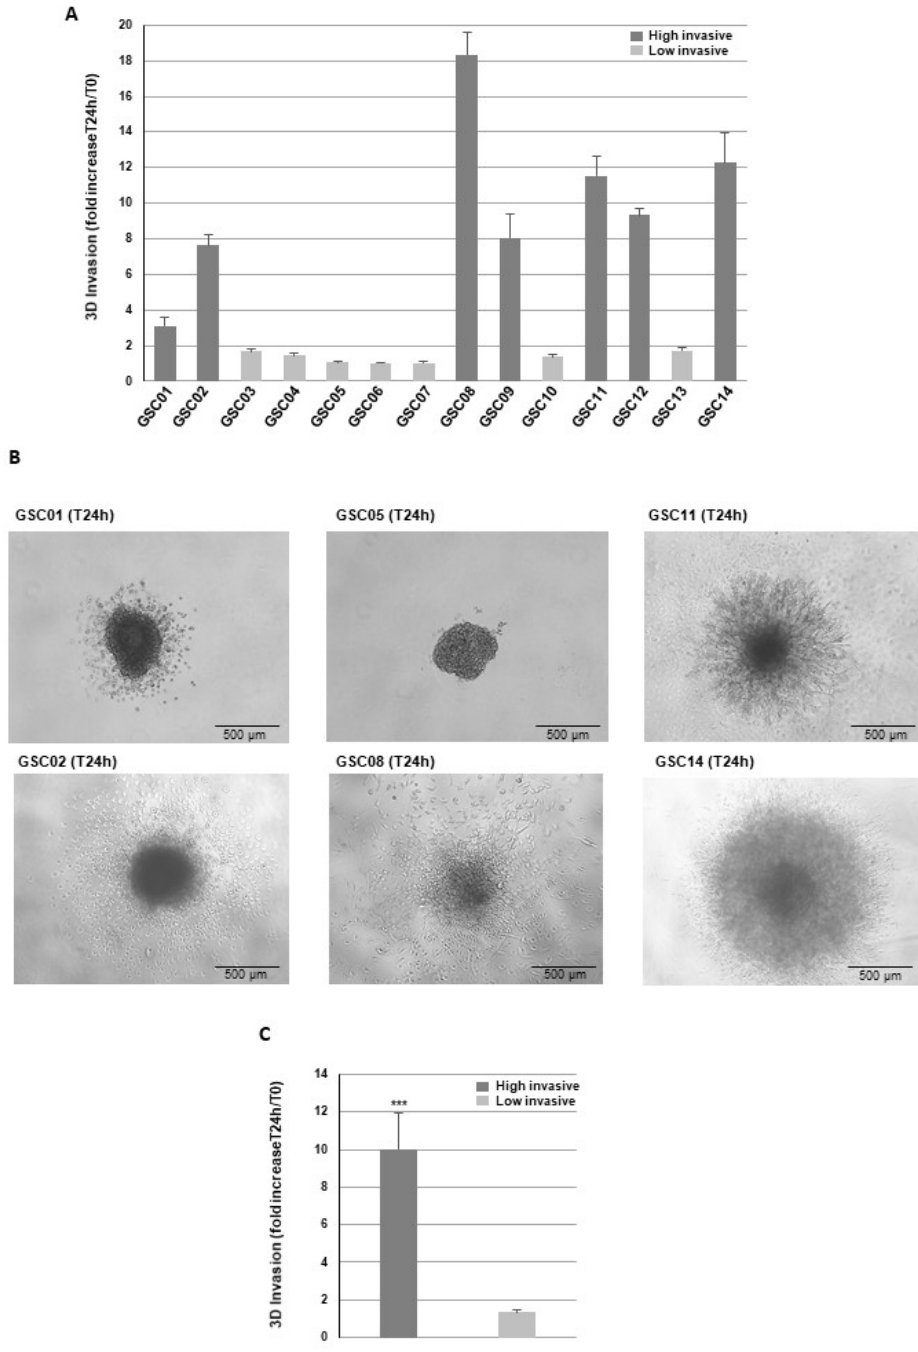
Figure 1. Invasive capacities of GBSC. Primary cultures of GBSC isolated from 14 patient samples were analyzed in 3D invasion assays. ( A , C ) Quantification of tumor cells invasion was performed, 24 h after embedding, on 3 independent experiments as described in “Methods”. Cells were classified into two groups, highly invasive and low invasive, based on a ratio invading cells area/sphere area greater than 2. ( B ) Representative micrographs of Matrigel-embedded GB spheroids taken 24 h after invasion into the Matrigel. ( B ) Results are presented as means ± SD. *** p < 0.001. Figure 1C shows the significant difference in the invasive capacity between the two